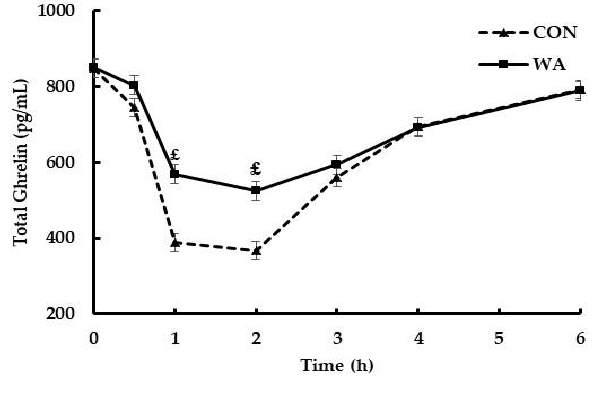
Table 3. Gut peptide and insulin hormone iAUC over 6-hour postprandial day 1 . Hormones WA